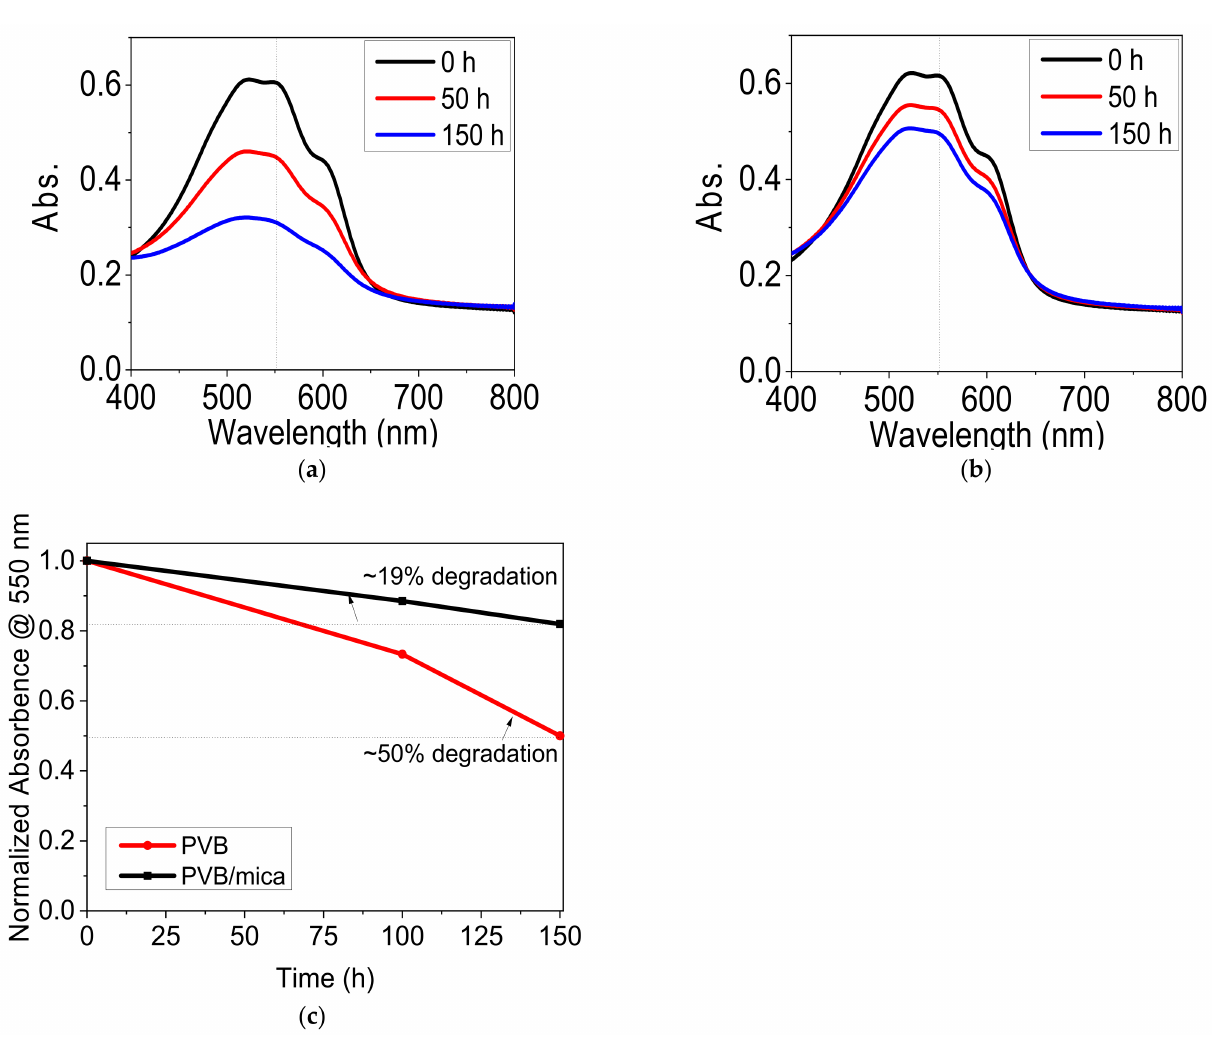
Figure 8. UV-vis spectra of directly coated P3HT films on PET substrate from both sides with ( a ) a pristine PVB (100 µ m thick) and ( b ) PVB filled with 25 vol% of mica flakes (~100 µ m thick) and ( c ) normalized absorbance loss at 550 nm of P3HT coated with pristine PVB and PVB filled with flakes for an illumination time of 150 h with sun simulator light in ambient